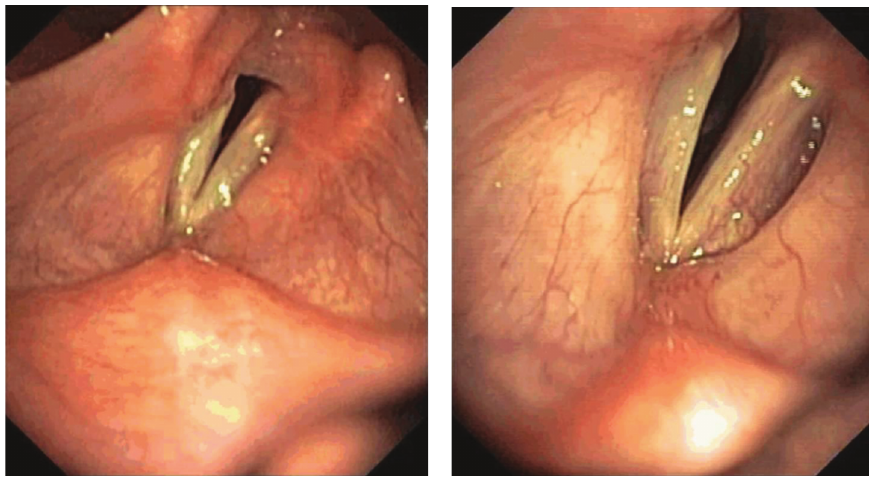
Figure 2: Inspiratory adduction of the anterior portion of the vocal folds with formation of a posterior